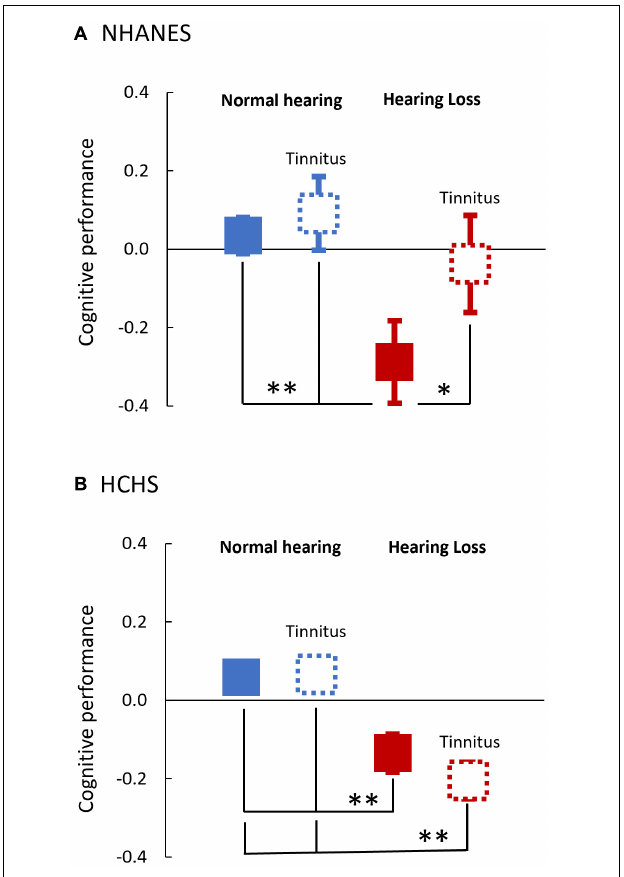
FIGURE 3 | Adjusted Mean Cognitive Performance of the Four Study Groups in both NHANES (A) and HCHS (B) . One-way ANOVAs with the post hoc Bonferroni test were used for between-groups comparison of the adjusted cognitive z-score. Boxes denote the adjusted mean and error bars denote the 95 CI%. Blue denotes normal hearing and red denotes hearing loss. Solid lines are of No tinnitus, and dashed lines are of tinnitus. *, **indicates a significant difference in the adjusted cognitive performance between groups ( ∗ p < 0.05; ∗∗ p <